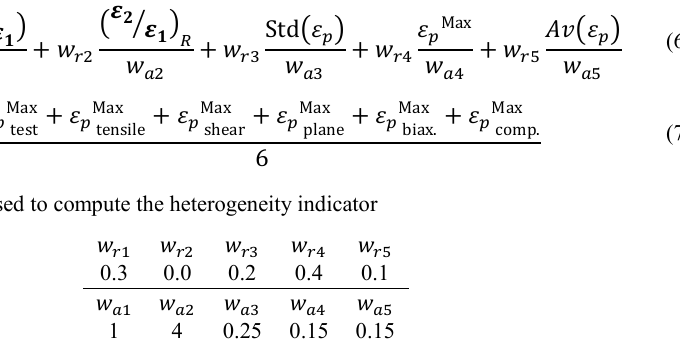
Table 3. Values of the heterogeneity indicator and its components for the notched